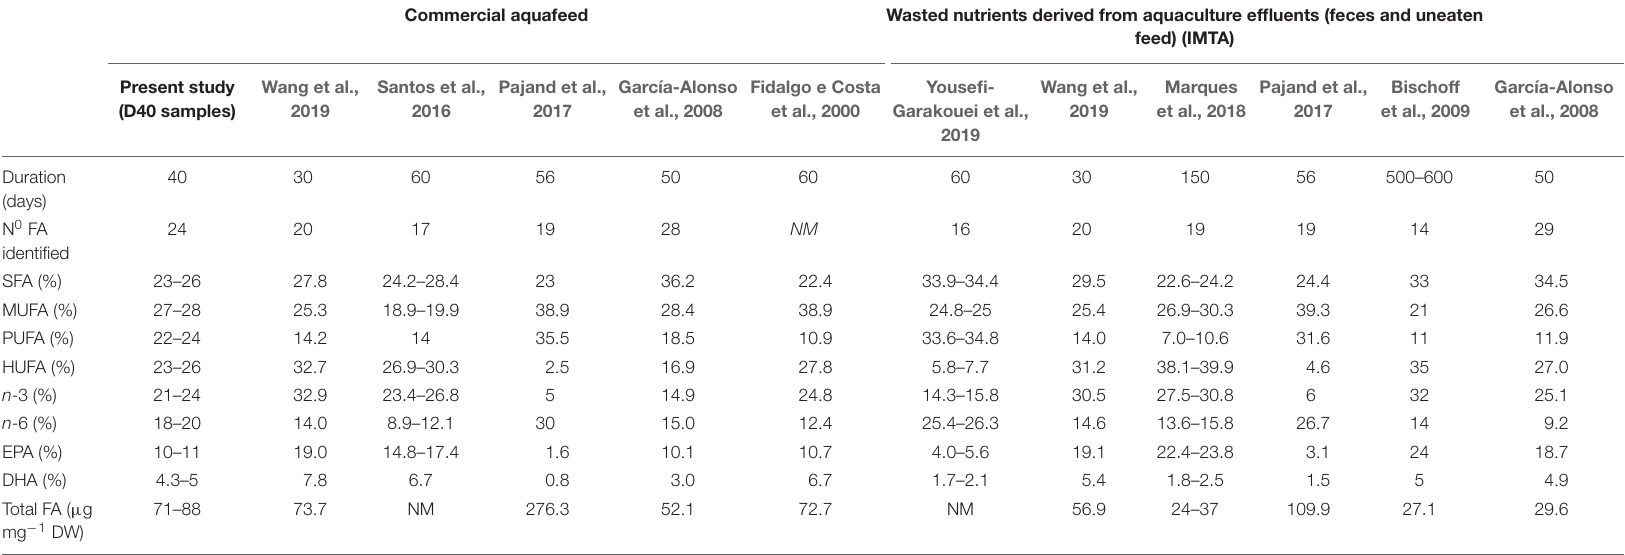
TABLE 5 | Summary of the fatty acid (FA) profile of Hediste diversicolor reported from previous studies providing this species with a commercial aquafeed or wasted nutrients derived from aquaculture effluents. Commercial